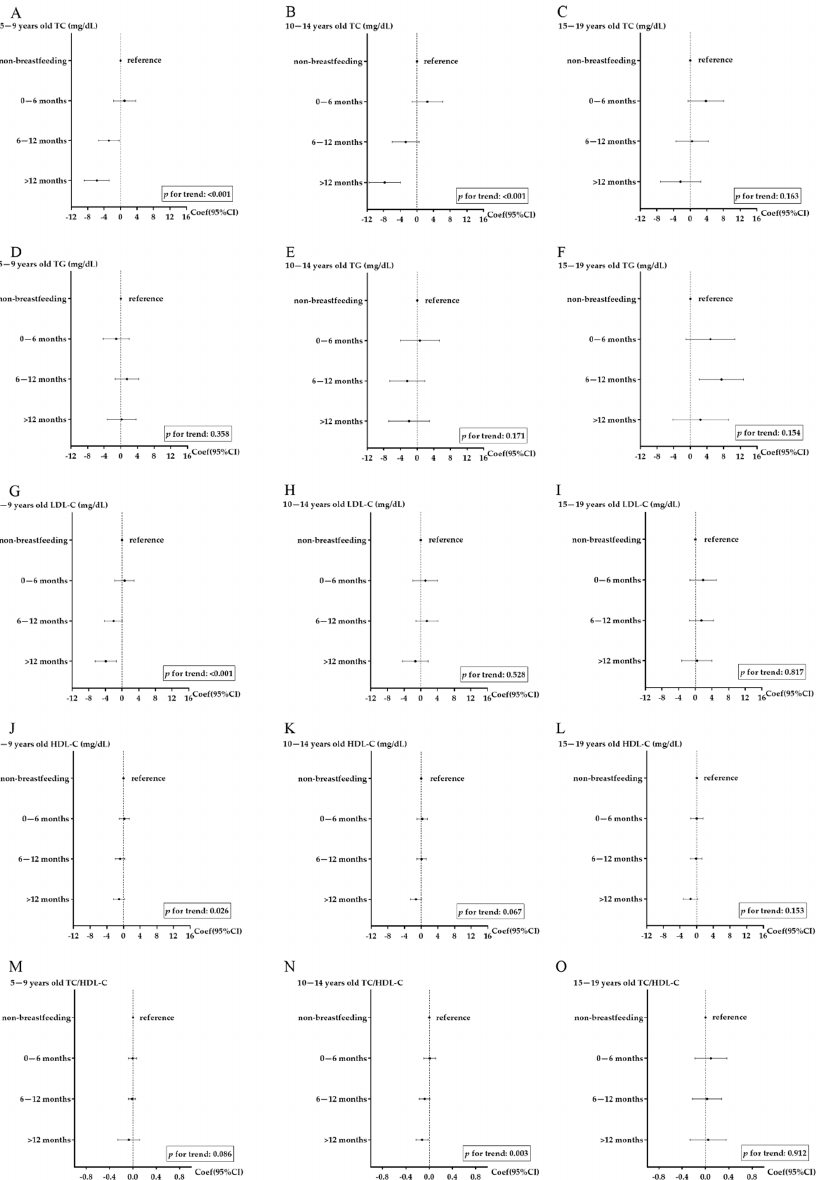
Figure 1. The differences in lipid levels among different breastfeeding groups, stratified by age group. ( A ): association between breastfeeding duration and total cholesterol (TC) in children aged 5–9 years old; ( B ): association between breastfeeding duration and TC in children aged 10–14 years old; ( C ): association between breastfeeding duration and TC in children aged 15–19 years old; ( D ): association between breastfeeding duration and triglyceride (TG) in children aged 5–9 years old; ( E ): association between breastfeeding duration and TG in children aged 10–14 years old; ( F ): association between breastfeeding duration and TG in children aged 15–19 years old; ( G ): association between breastfeeding duration and low-density lipoprotein cholesterol (LDL-C) in children aged 5–9 years old; ( H ): association between breastfeeding duration and LDL-C in children aged 10–14 years old; ( I ): association between breastfeeding duration and LDL-C in children aged 15–19 years old; ( J ): association between breastfeeding duration and high-density lipoprotein cholesterol (HDL-C) in children aged 5–9 years old; ( K ): association between breastfeeding duration and HDL-C in children aged 10–14 years old; ( L ): association between breastfeeding duration and HDL-C in children aged 15–19 years old; ( M ): association between breastfeeding duration and TC/HDL-C in children aged 5–9 years old; ( N ): association between breastfeeding duration and TC/HDL-C in children aged 10–14 years old; ( O ): association between breastfeeding duration and TC/HDL-C in children aged 15–19 years old. Notes: adjusted for region, sex, parental education level, children’s BMI, physical activity, sugar-sweetened beverage consumption, meat consumption, and frequency of high-energy food and fried